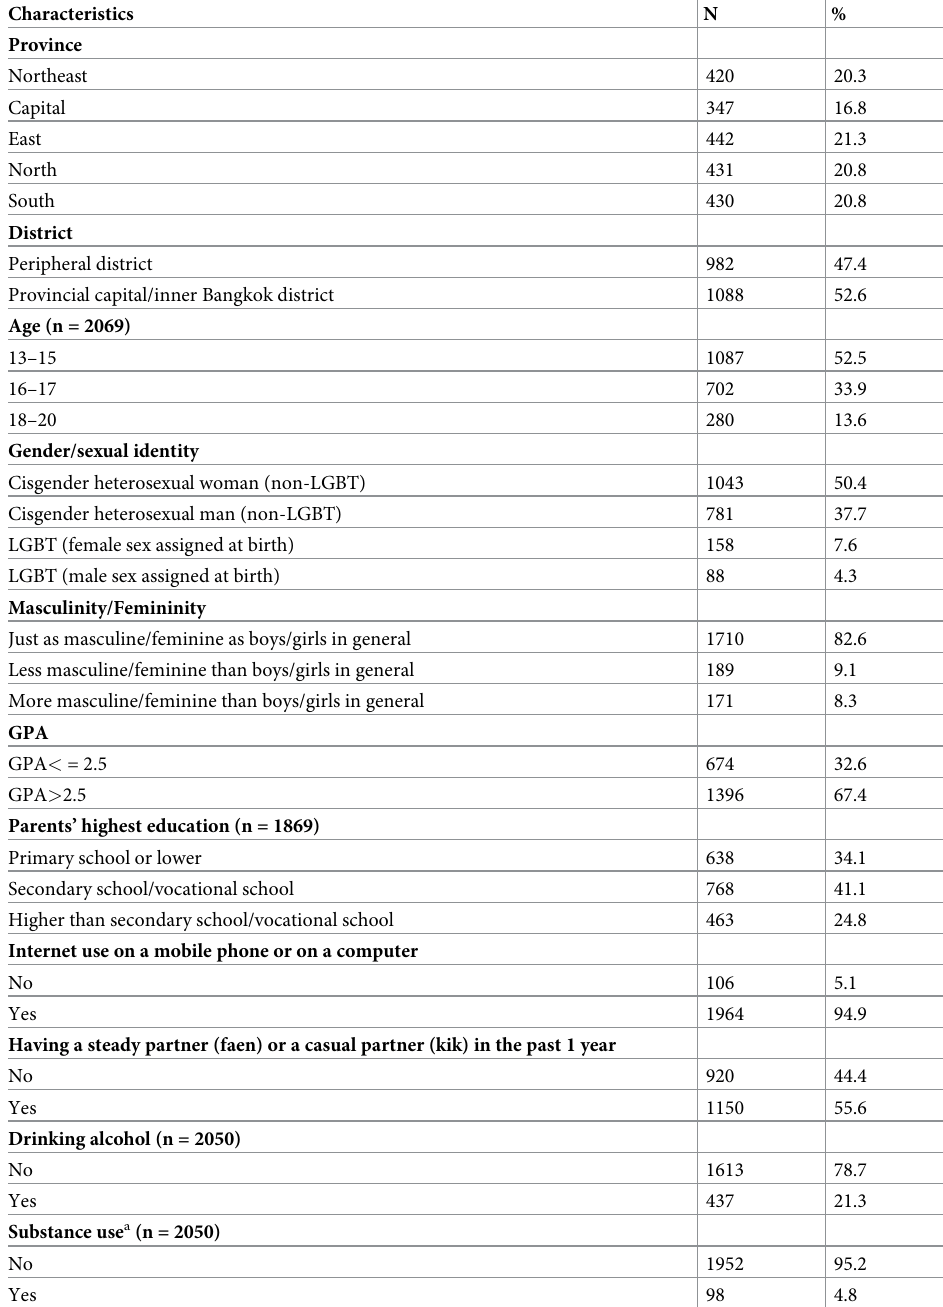
Table 1. Participant characteristics (N =